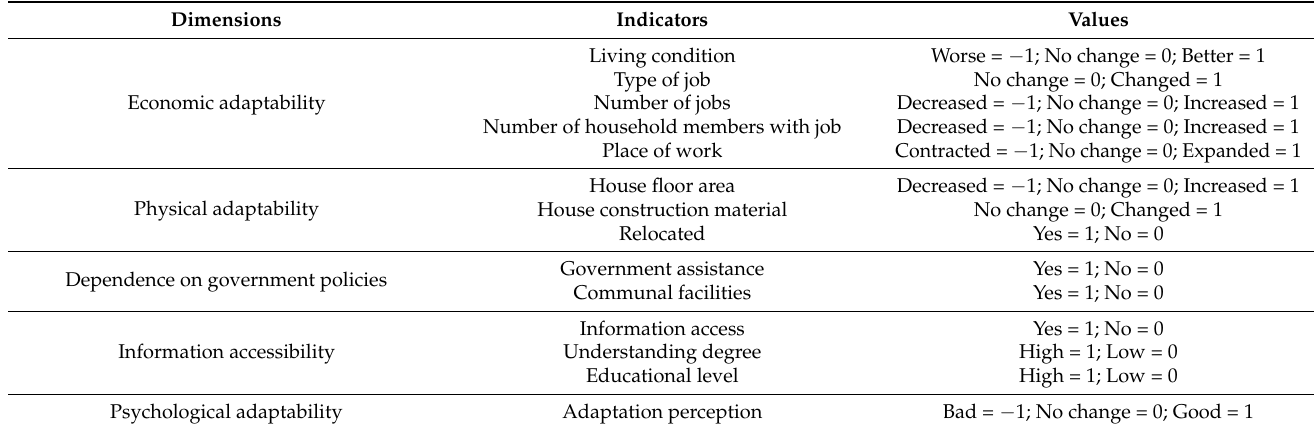
Table 2. List of indicators for each dimension of household adaptation